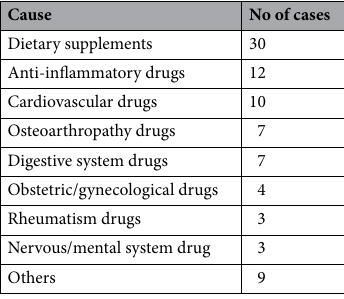
Table 4. Indications of drugs that caused liver injury in 79 Chinese DILI patients, induced by herbal medications. DILI drug-induced liver injury.